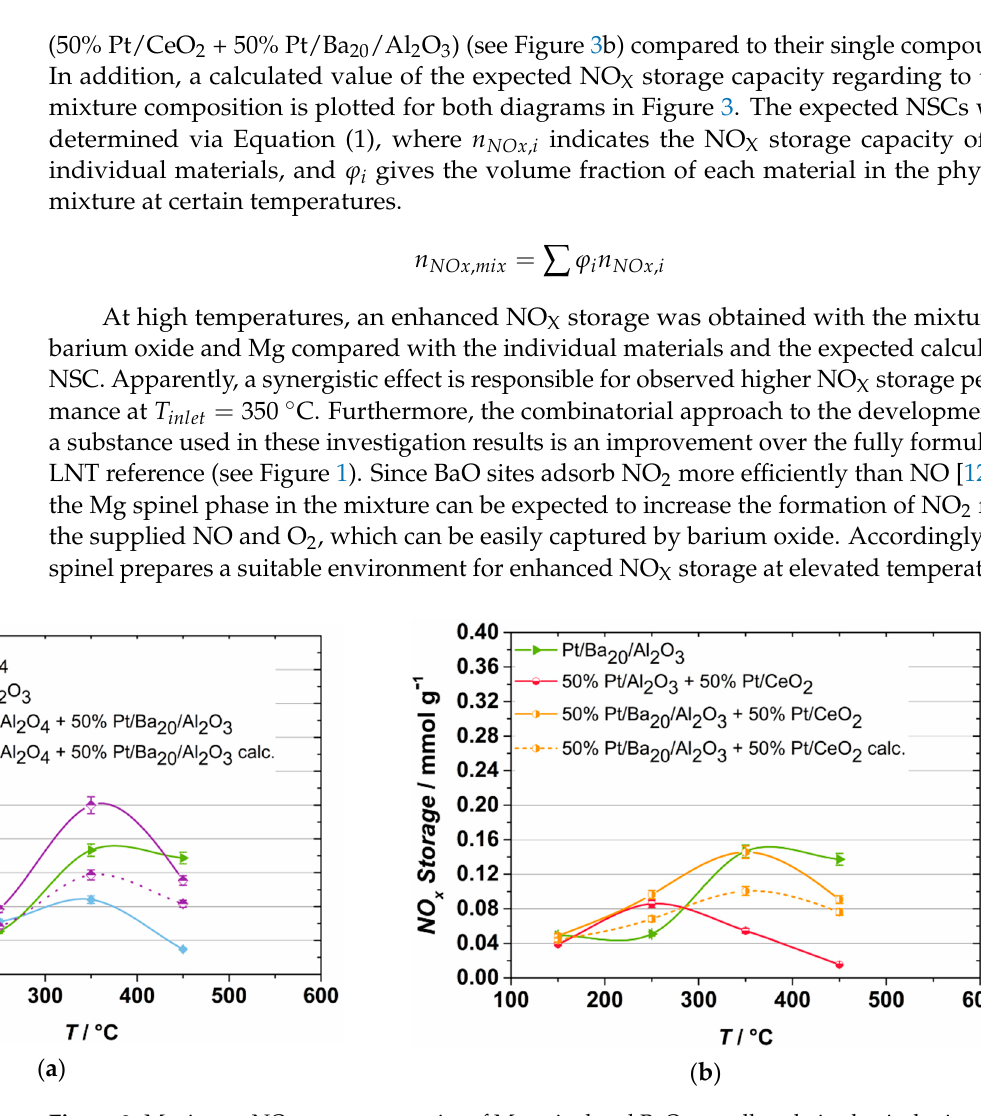
Figure 3. Maximum NO X storage capacity of Mg spinel and BaO as well as their physical mixture ( a ) and that of ceria and BaO with their physical mixture ( b ) in comparison to the expected NO X storage performance of the mixtures (dotted lines).